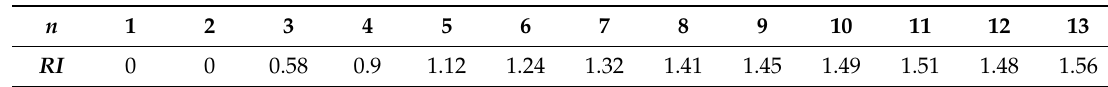
Table 3. Values of RIn